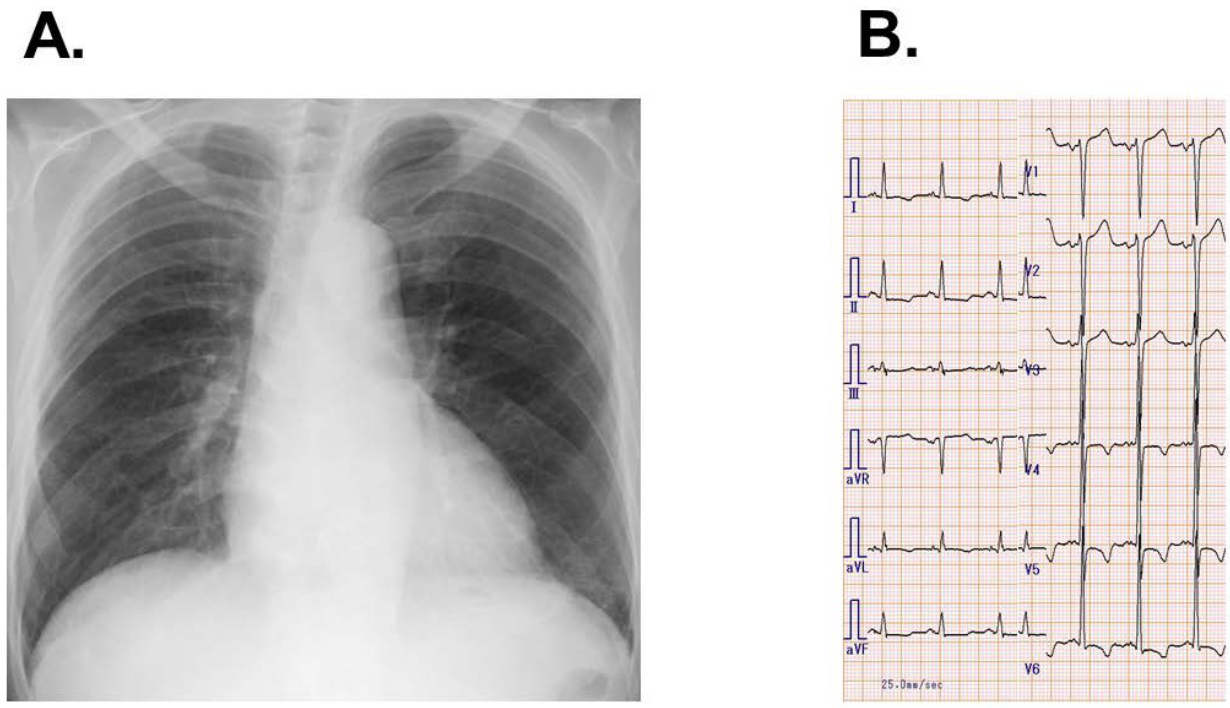
Figure 1. Chest X-ray ( A ) and electrocardiogram ( B ) on admission. Transthoracic echocardiography showed a left ventricular end-diastolic diameter of 62 mm, left ventricular ejection fraction 22%, and a mild mitral regurgitation (Figure 2A). Intraventricular septum and posterior wall thickness were 8/9 mm. E/e’ ratio was 17.9. The overlap length between the two waves was +154 msec. Cardiac output was 2.9 L/min, which was estimated using AESCULON mini [4]. Plasma B-type natriuretic peptide was 161 pg/mL and six-minute walk distance was 369 m. He was suspected of dilated